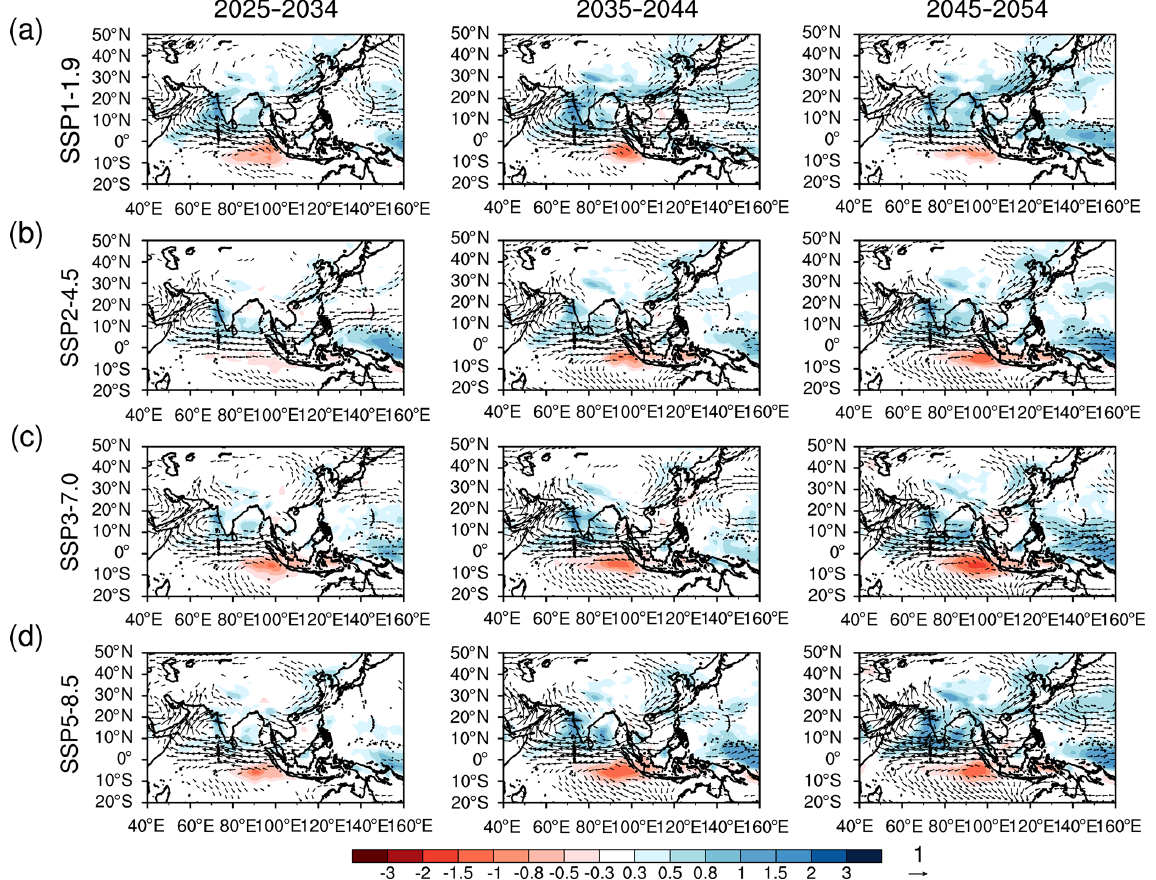
Figure 11. CMIP6-mean JJA-mean precipitation (mmd − 1 ) and 850hPa wind anomalies (ms − 1 ) for 2025–2034, 2035–2044, and 2045–2054 vs. 1980–2014 from (a) SSP1-1.9, (b) SSP2-4.5, (c) SSP3-7.0, and (d)